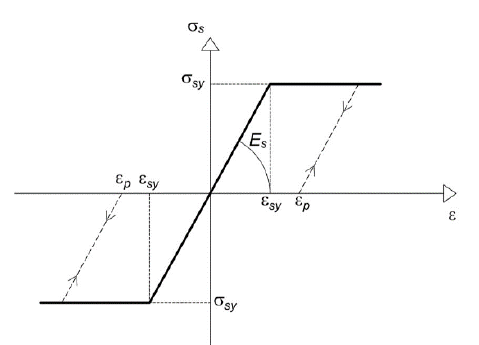
Figure 4. Steel constitutive